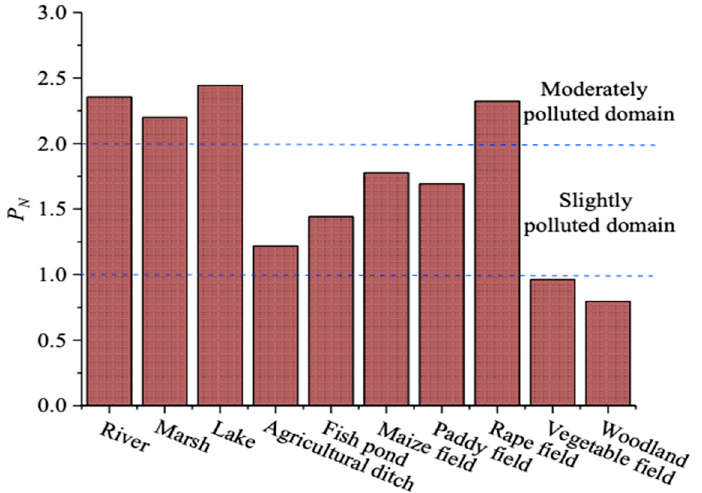
Figure 4. Nemerow's synthetical contamination index ( P N ) in different landuse types of the wetland.